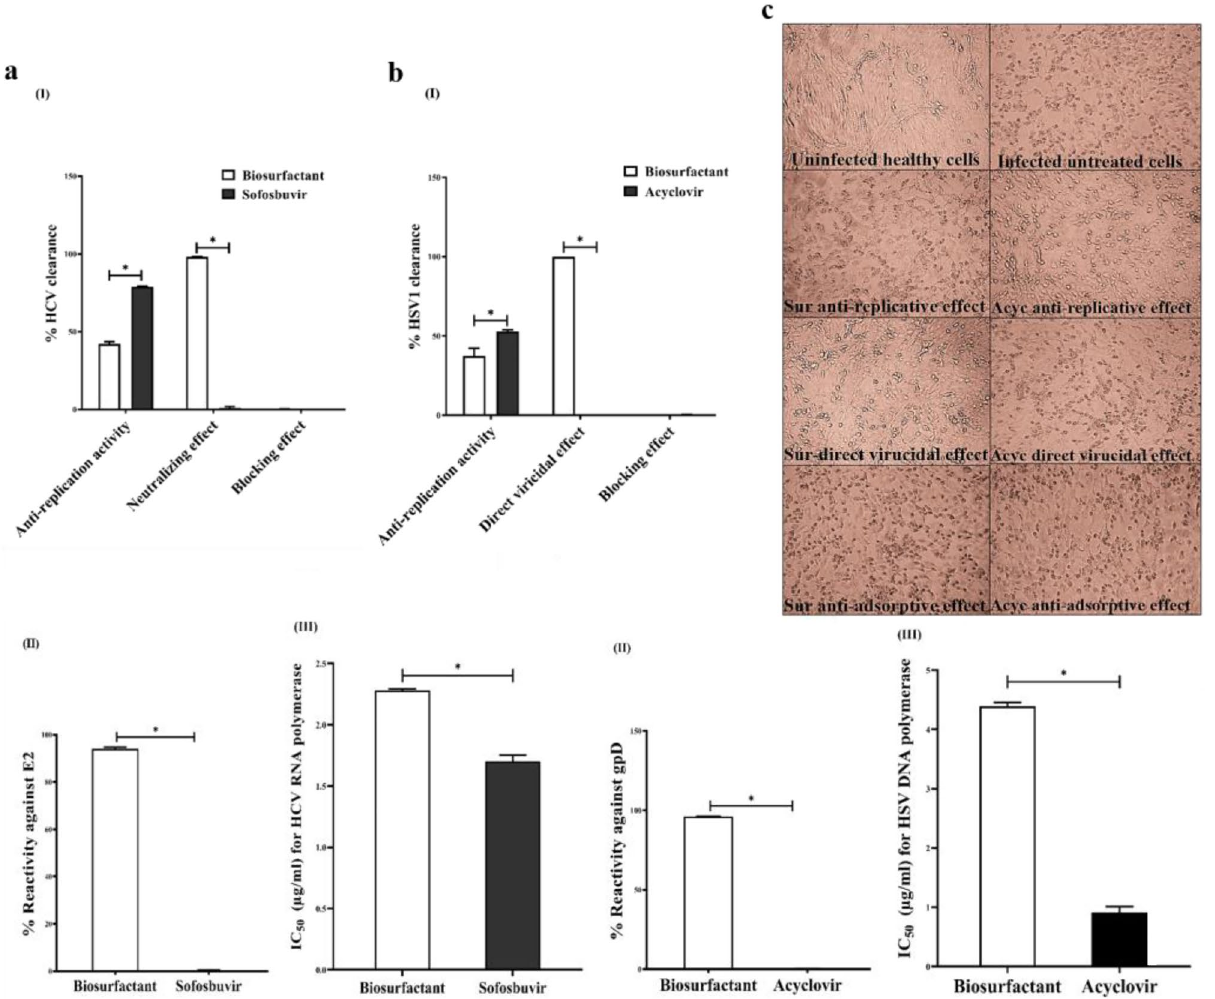
Figure 6. Antiviral activity of biosurfactant with unveiling its mechanism(s)-mediated antiviral mode, compared to standard drugs against ( a ) HCV and ( b ) HSV1. ( I ) QPCR-estimated HCV and HSV1 eliminating percentage, relative to the untreated infected cells, in three suggested modes of antiviral action, including anti-replicative, neutralizing and blocking effects at safe concentration (EC 100 ) of biosurfactant, ( II ) the relative reactivity % of biosurfactant against HCV-envelope protein (E2) and HSV-glycoprotein (gp) D and ( III ) IC 50 values of biosurfactant for inhibiting HCV RNA polymerase and HSV DNA polymerase. All data are expressed as mean ± SEM and considered significantly different at p <